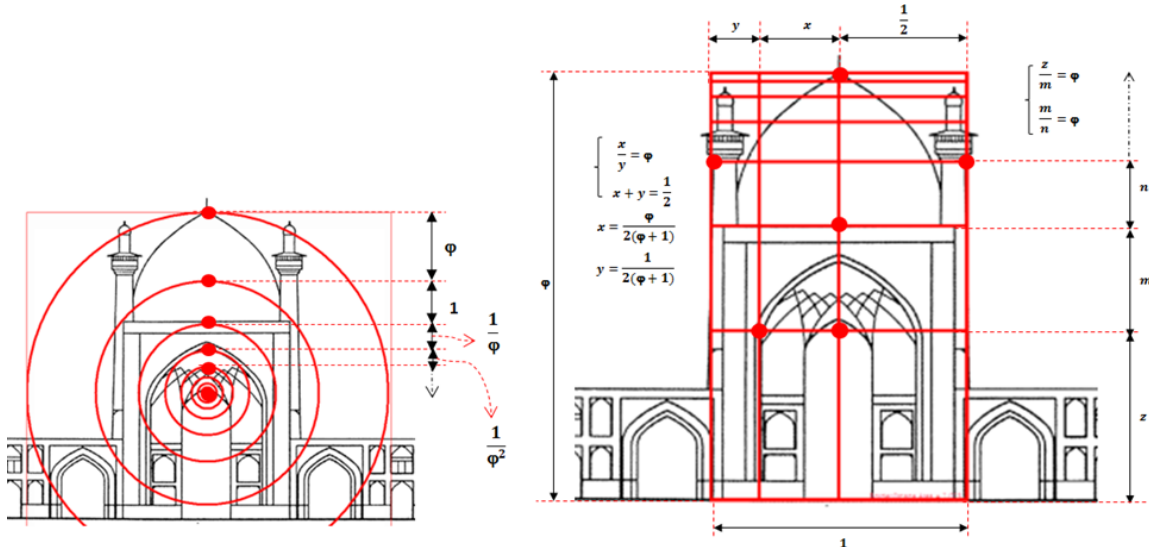
Figure 16: Placing main dome with main porch in golden rectangle; (right pic) and adaption tips of dome, finials, porches, and the shoul- ders of the main porch, with golden distances